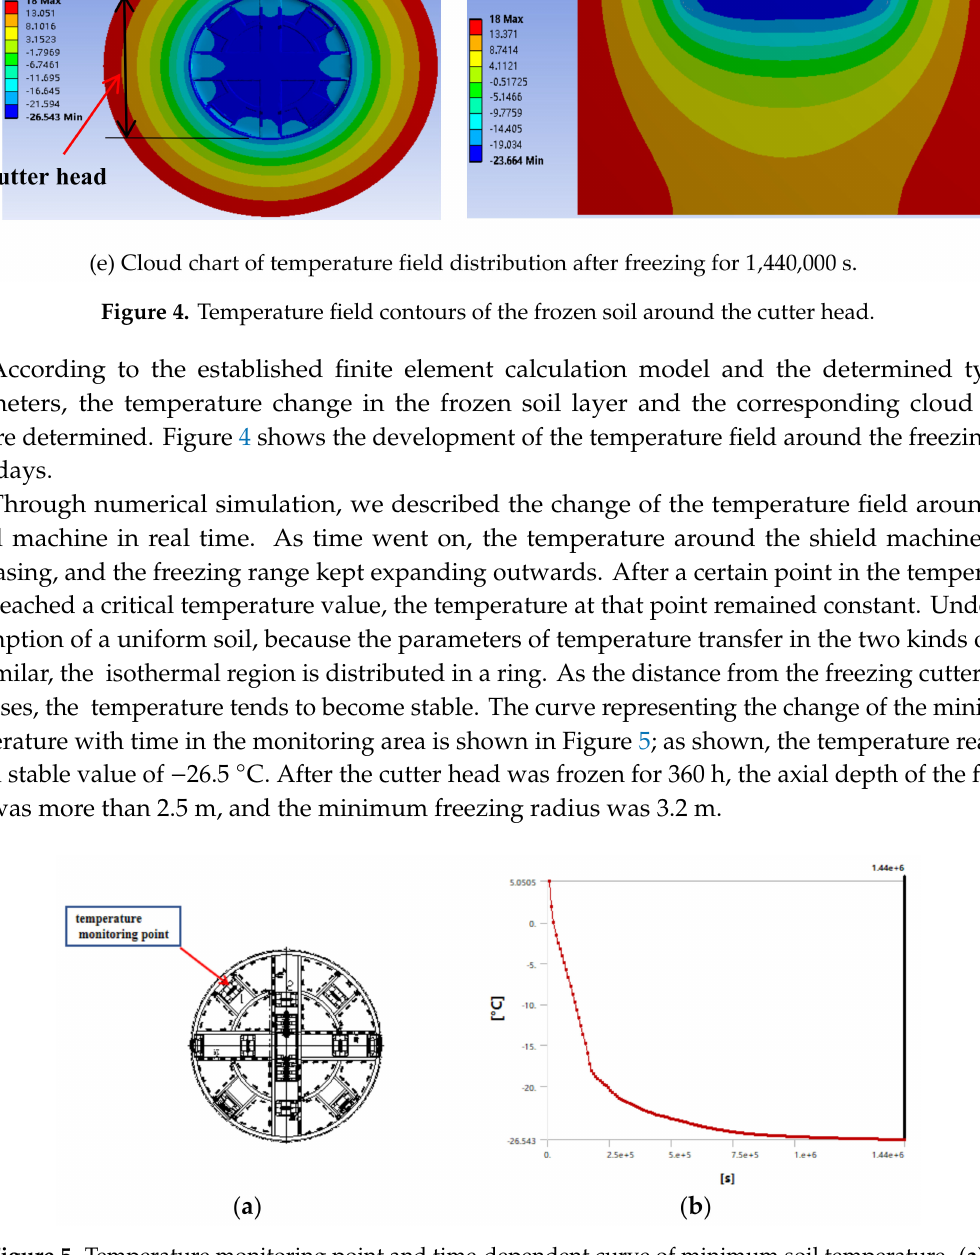
Figure 5. Temperature monitoring point and time-dependent curve of minimum soil temperature. ( a ): Temperature monitoring point; ( b ): time-dependent curve of minimum soil